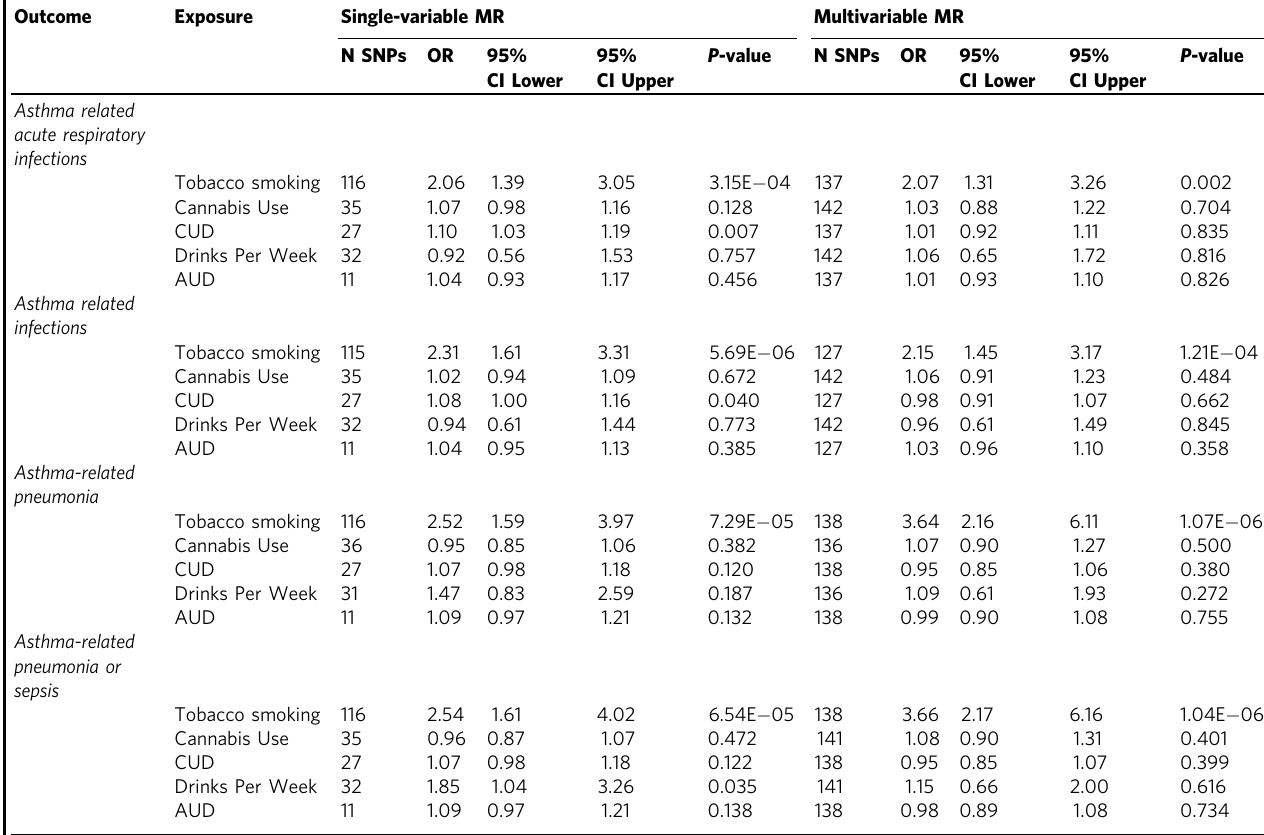
Table 2 Single variable and multivariable MR results of the genetic liability of alcohol, cannabis and lifetime smoking exposures on asthma-related respiratory